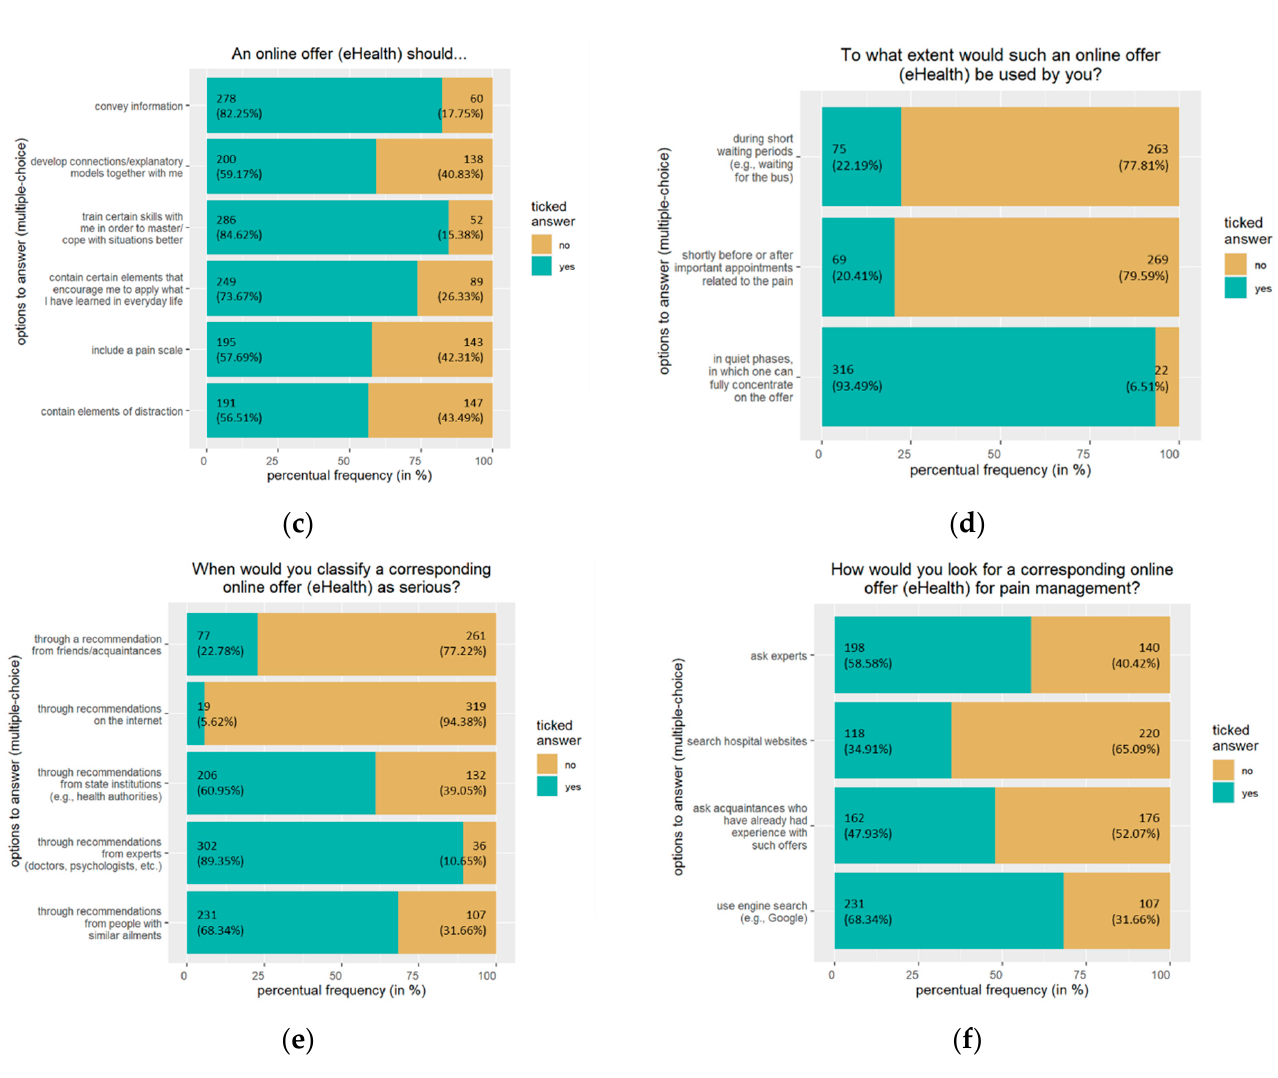
Figure 1. n = 338. The bars show absolute frequency (percentual frequency). Shown above are the participants’ responses regarding ( a ) the availability of an online o ff er for pain management; ( b ) the format of an online o ff er for pain management; ( c ) the thematic aim of an online o ff er for pain man- agement; ( d ) their usage of an online o ff er for pain management; ( e ) the seriousness of recommen- dations for an online o ff er; ( f ) their research for an online o ff er for pain